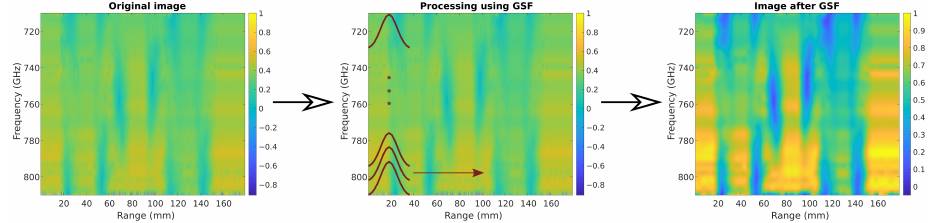
Figure 4. Principle of proposed Gauss Spotlight Filter (GSF). The filter moves through the spectrogram on every vertical position or every target